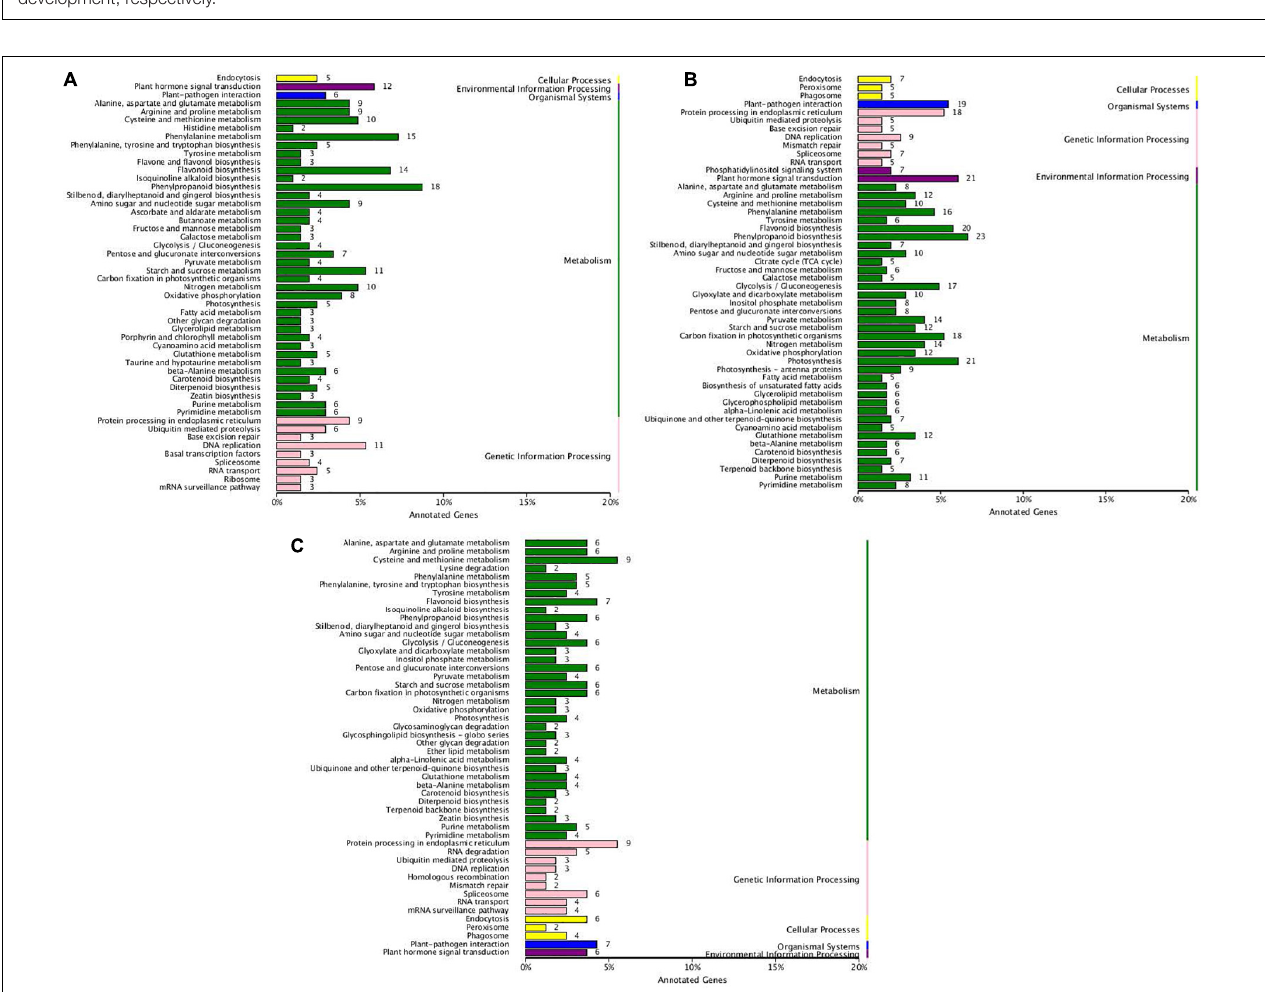
FIGURE 3 | KEGG enrichment of DEGs between T. grandis ‘Xifei’ and T. grandis ‘Dielsii’ at the development of the initiative (A) , rapid rise (B) , and stationary (C) oil accumulation.